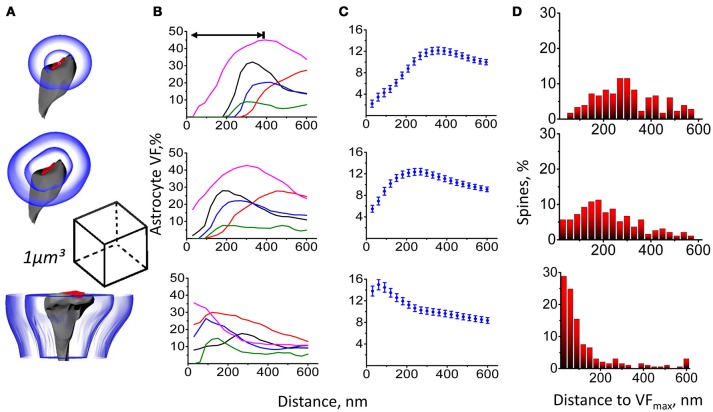
Astrocyte VF distribution around dendritic spines. (A) Astrocyte VF was measured between equidistant surfaces constructed around PSD center (top), around PSD surface (middle) and around side surfaces of the dendritic spine (bottom). (B) Changes of astrocyte VF with the distance from PSD center (top), from PSD surface (middle) and from spine surface (bottom) for 5 individual spines. Double-sided arrow indicates the distance to the VFmax. (C) Summary data as in (B) are presented as mean ± SEM for 207 spines. (D) Percentage of dendritic spines with VFmax at a different distance from PSD center (top), PSD surface (middle), and spine surface (bottom). The bin size of 30 nm was equal to the distance step in (A–C).